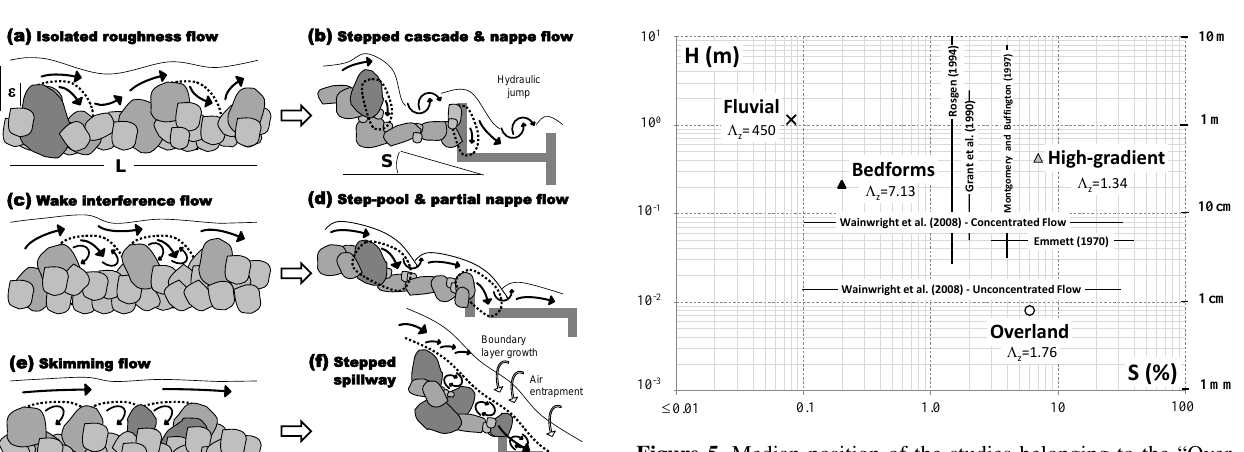
Figure 5. Median position of the studies belonging to the “Over- land”, “High-gradient”, “Bedforms”, and “Fluvial” flow typologies, plotted on the ( S : slope, H : water depth) plane, with indication of the associated inundation ratio ( (cid:51) z = H/ε , and ε is the roughness size). This figure was assembled from information available in the studies cited in Appendix